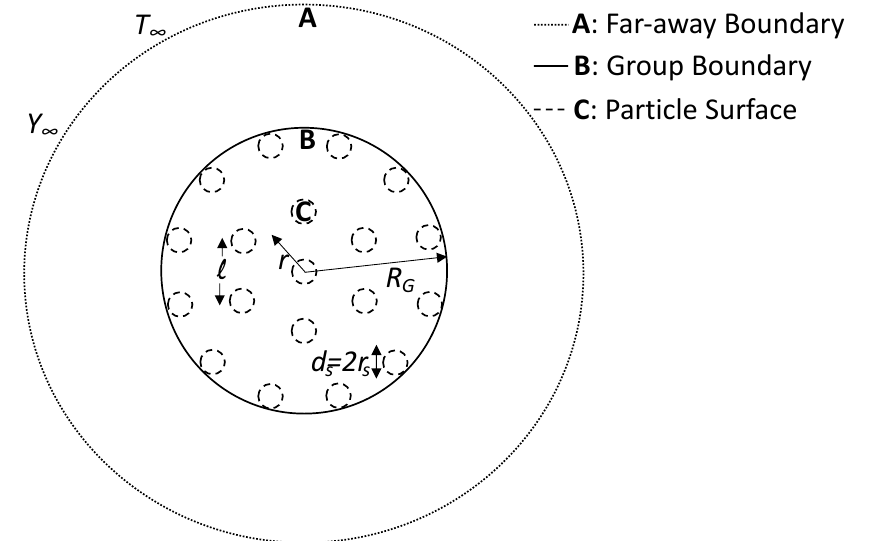
Figure 3. Illustration of combustion for a group of nanothermites and the different regions of A, B and